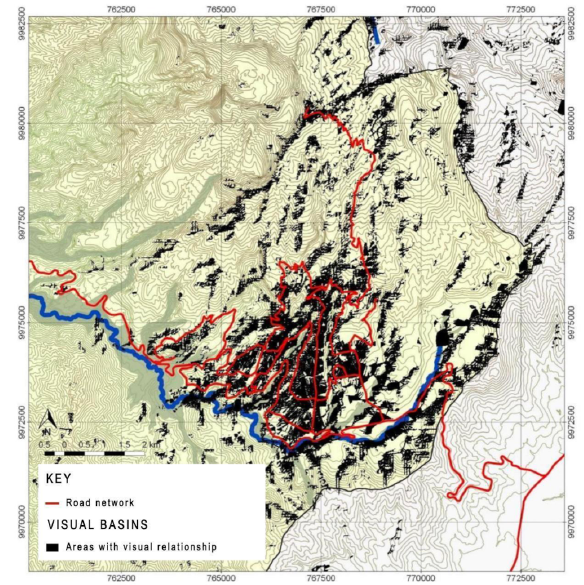
Figure 12: Visual